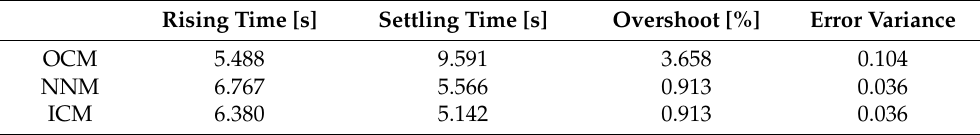
Table 4. Tracking performance indexes of three control methods.